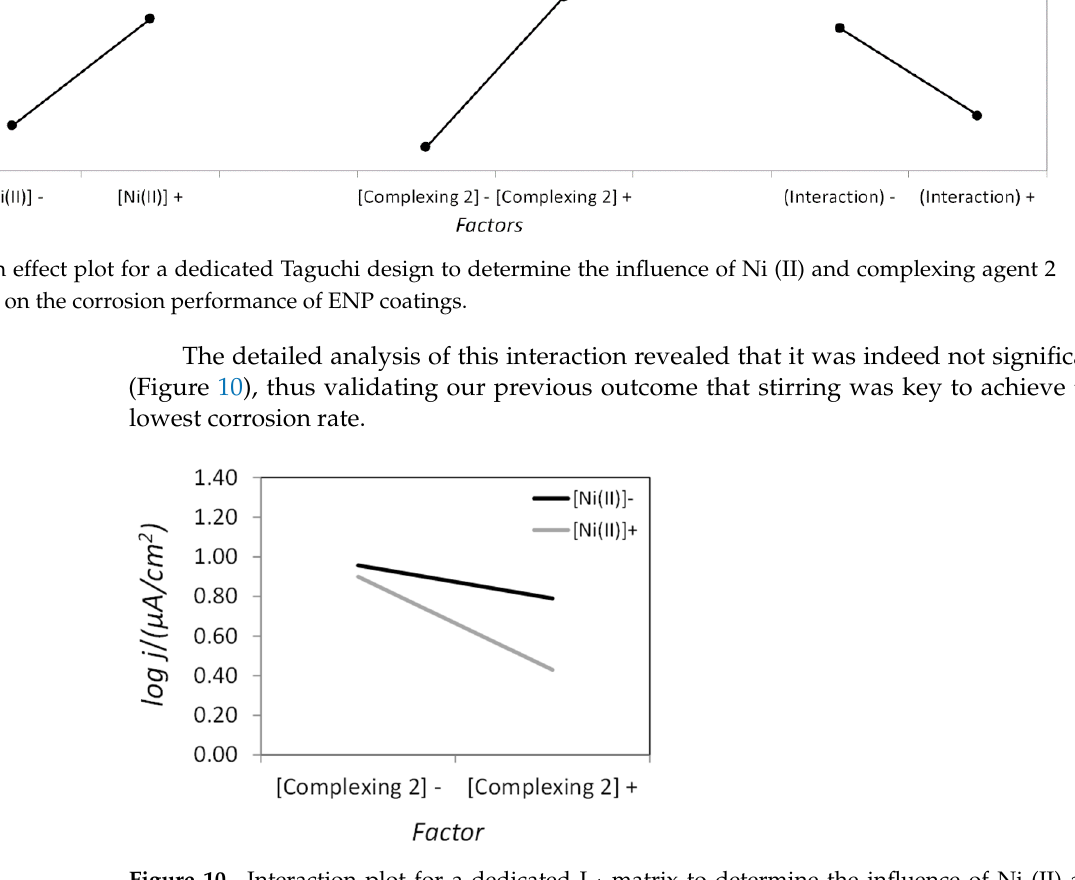
Figure 10. Interaction plot for a dedicated L 4 matrix to determine the influence of Ni (II) and complexing agent concentrations on the corrosion performance of the ENP coatings.